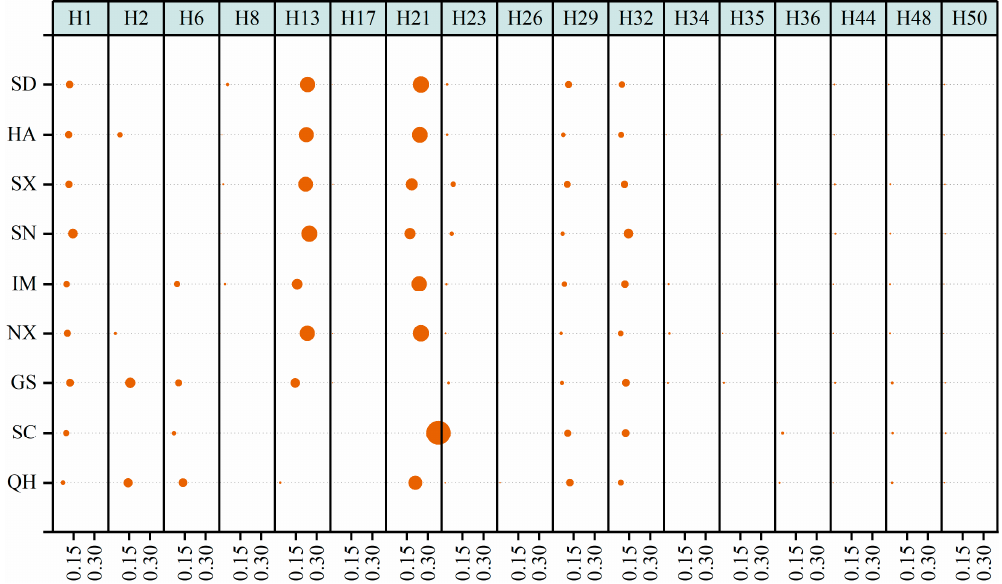
Figure 11. The degree of limitation to the Happy River Index of the assessment index of each provinces and region along the Yellow River. Here, the labels “QH”, “SC”, “GS”, “NX”, “IM”, “SN”, “SX”, “HA”, and “SD” refer to the provinces and regions of Qinghai, Sichuan, Gansu, Ningxia, Inner Mongolia, Shaanxi, Shanxi, Henan, and Shandong, respectively.